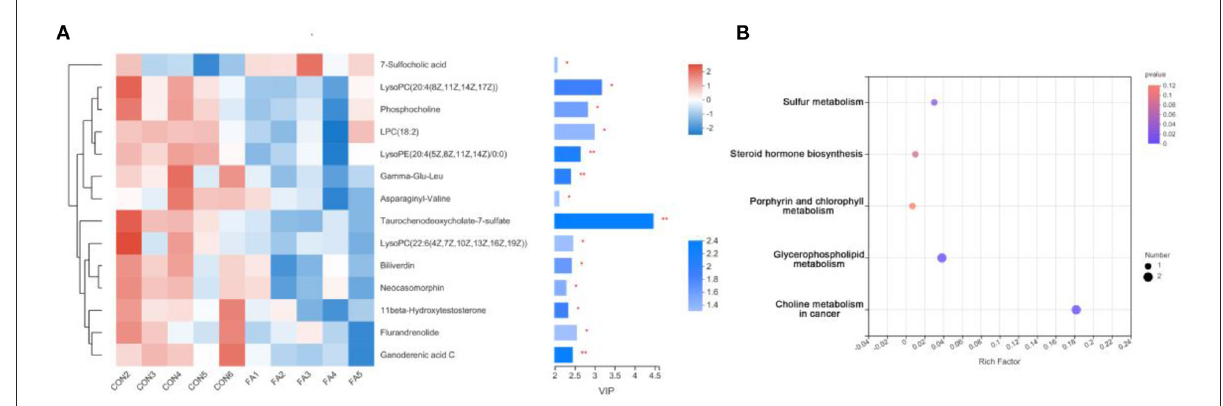
FIGURE4 Effect of FA on gut metabolomic. (A) VIP scores with the expression of the heat map of intestinal metabolites in the FA-H and control groups. The selected metabolites were those with VIP ≥ 2 and P < 0.05. * P < 0.05, ** P < 0.01. (B) Comparison of the KEGG enriched pathways of differential gut metabolites in the FA-H and in the control group. The size of the bubble represents the number of enriched metabolites, and the color indicates enrichment significance ( P-value